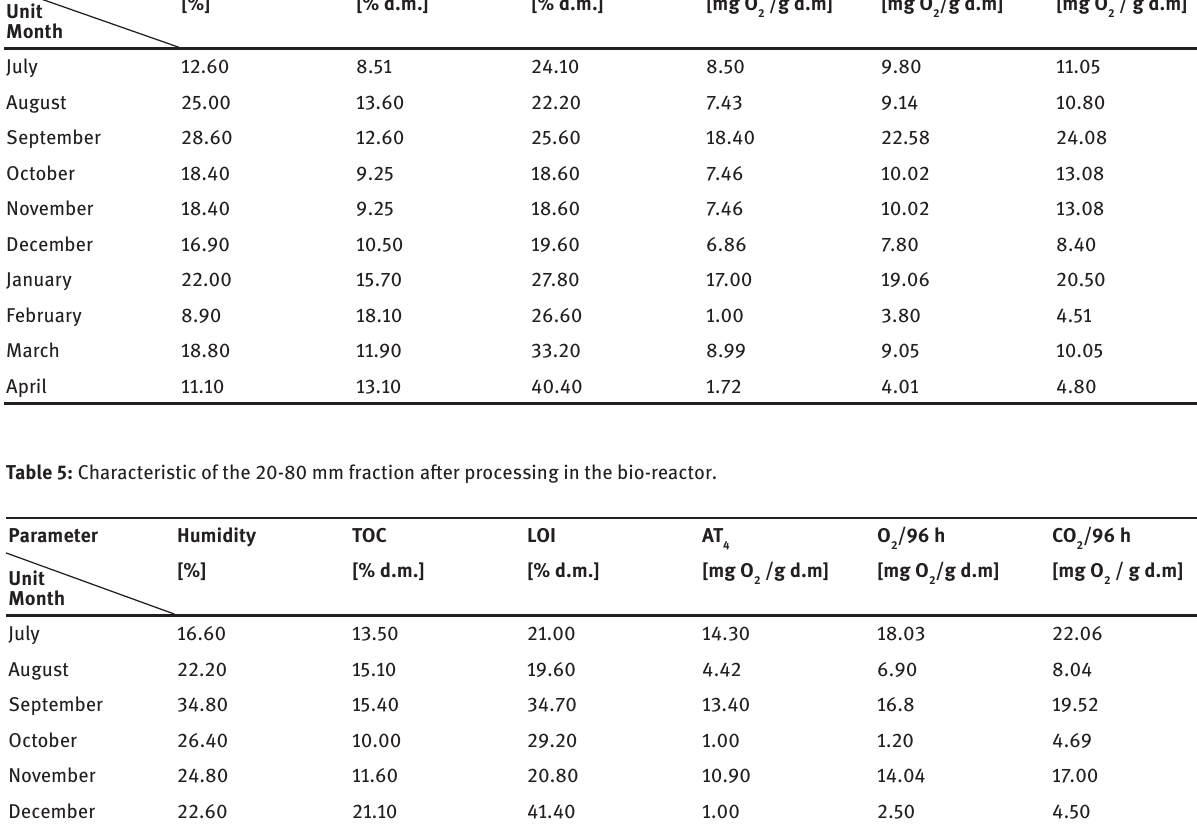
Table 4: Characteristic of the 0-20 mm fraction after processing in the bio-reactor. Parameter Humidity